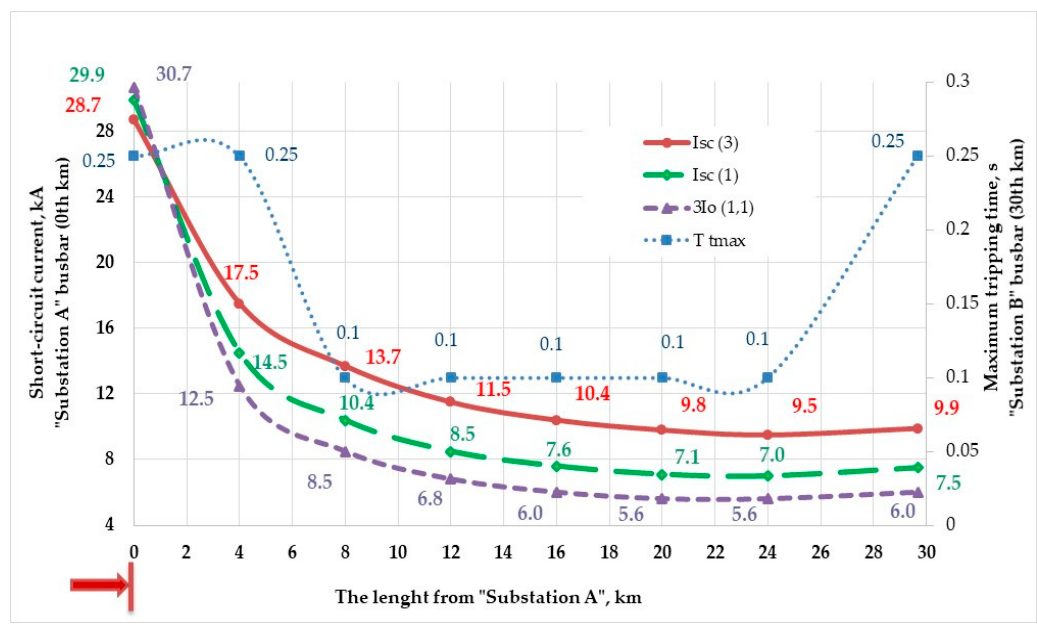
Figure 2. Estimated short-circuit currents along 110 kV “overhead power line (OHL) No.1” from “Substation A” (zeroth km) toward “Substation B” (30th km).